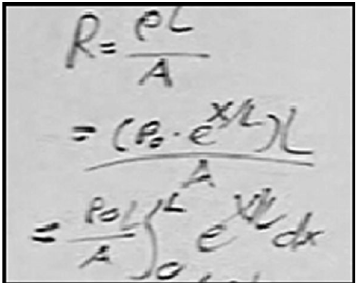
FIG. 5. Equation set up by Phil.